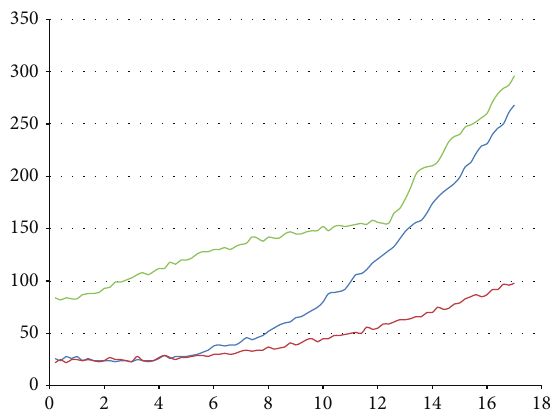
Figure 9: The fluorescent intensity of Output strands from exper- iment (A3). 𝑥 -axis is reaction time and 𝑦 -axis is the fluorescent intensity of 6-FAM. From bottom up, the curves correspond to cases of concentrations of magnesium ion, being 0 (blue), 25 𝜇 M (red), and 100 𝜇 M (green),